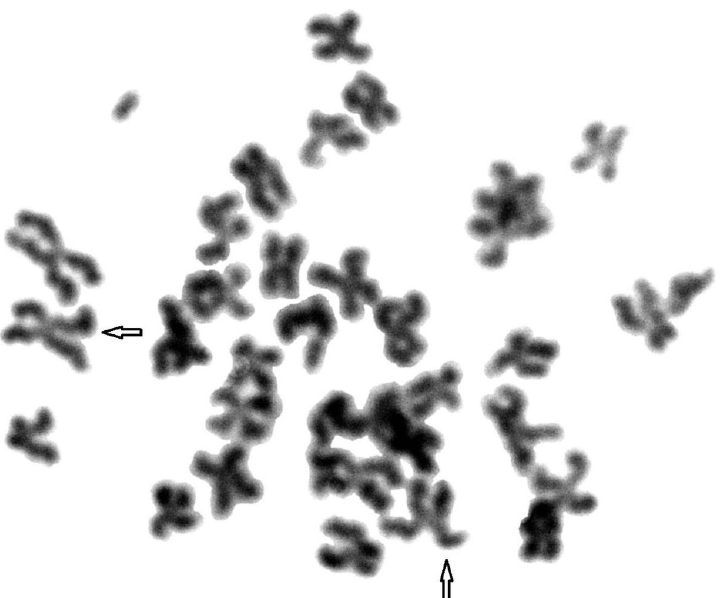
Figure 2. Fragile sites in the chromosomes of silver foxes. Damage marked with arrows.